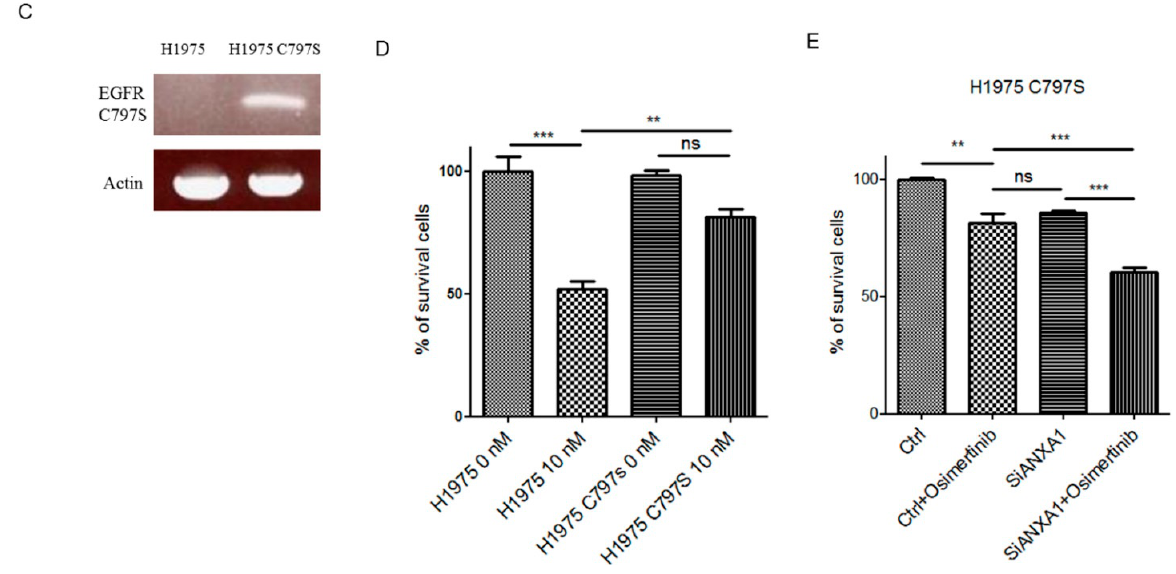
Figure 6. ( A ). Western blot analysis of ANXA1-GFP in H1975 and H1650 lung cancer cells transfected with pCMV6-AC-GFP (EV) and pCMV6-ANXA1-GFP (ANXA1). Cell numbers were determined in ( B ) H1975 and H1650 lung cancer cells treated with or without 10 (H1975) or 20 nM (H1650) of Osimertinib for 72 h. Cell numbers were normalized to the EV group. The experiments were performed in triplicate. ( C ) RT-PCR of the ectopic EGFR in H1975 lung cancer cells transfected with L858R + C797S EGFR mutations (H1975C797S). ( D ) Cell numbers were determined in H1975 and H1975C797S